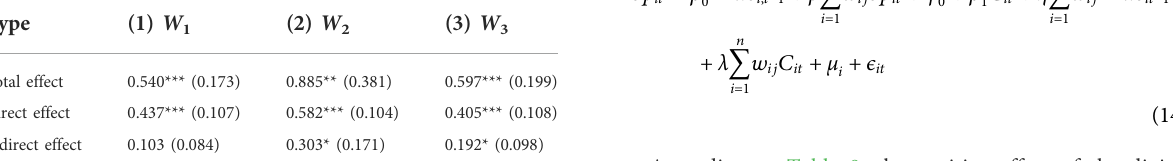
TABLE 7 Estimated results of total, direct, and indirect